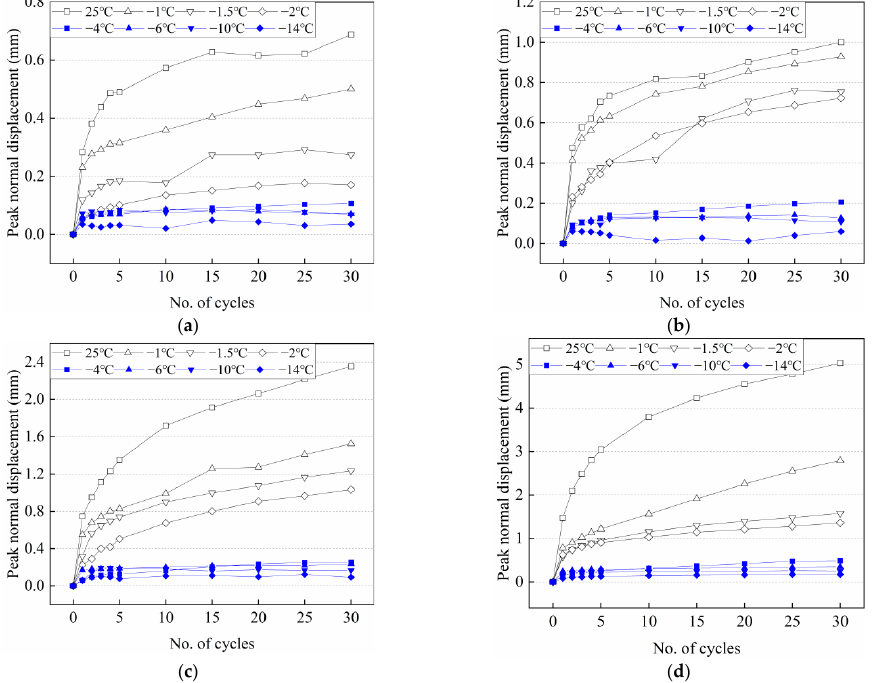
Figure 13. Peak normal displacement with the number of cycles for cement-treated sand–concrete interface at various conditions. ( a ) 100 kPa; ( b ) 300 kPa; ( c ) 500 kPa; ( d ) 700 kPa. Figure 14a depicts the variation of the maximum normal displacement with temperature for various normal stresses. Because of significant ice bondage at lower temperatures, the maximum normal displacement under the same normal stress decreases with decreasing temperature, resulting in less breakage. Furthermore, for higher normal stresses, the maximum normal displacement decreases faster. The increase in normal stress presses and melts the ice crystals at the surface faster, resulting in increased breakage that leads to the temperature significantly impacting the variation of the normal displacement. The variation of the maximum normal displacement with the normal stress at different temperatures is plotted, as shown in Figure 14b. The maximum normal displacement of the warm frozen cement-treated sand is significantly higher than that of the cold frozen cement-treated sand, indicating that the ice crystals formed on the surface and the strength of the frozen cement-treated sand have significant differences at different temperatures. For the same temperature, the maximum normal displacement increased with increasing normal stress, and this is consistent with the results of Zhao et al. [35] and Chang et al. [50]. However, the result is different from the research on the unfrozen sand- structure interface conducted by Pra-ai et al. [51]. Their study showed that the maximum normal displacement decreased with increasing normal stress. Chang et al. [50] attributed it to the pressure-melting behavior of frozen soil, which led to a decrease in the strength of the frozen soil. The results of this study verify this mechanism as follows: there are few ice crystals on the surface of warm frozen cement-treated sand, and the strength decreases